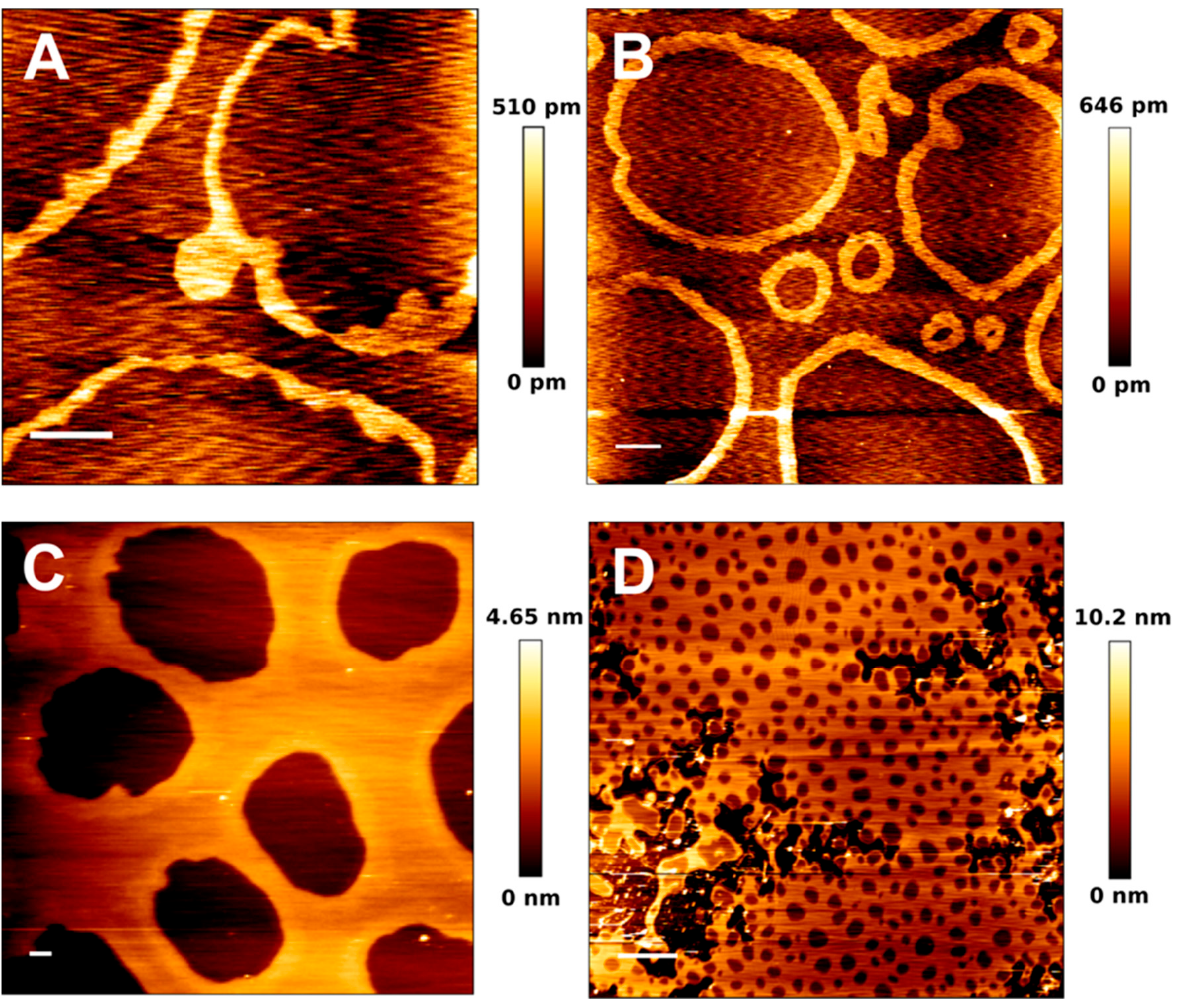
Figure 5. AFM images of pSM:pCer:Chol-based SPB at different mol ratios. pSM:pCer:Chol (54:23:23) ( A ), (60:20:20) ( B ), (66:17:17) ( C ), and (70:15:15) ( D ). Scale bars: 1 μ m. Panels A and B show the spontaneous formation of ‘ring-like’ phases in absence of proteins. Adapted from González-Ramírez et al. [99].